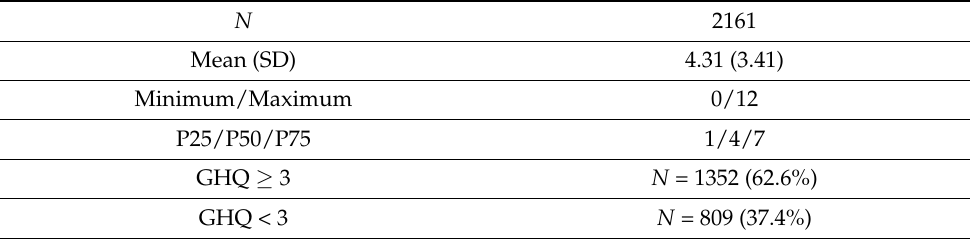
Table 2. Psychological Distress: General Health Questionnaire GHQ-12. N 2161 Mean